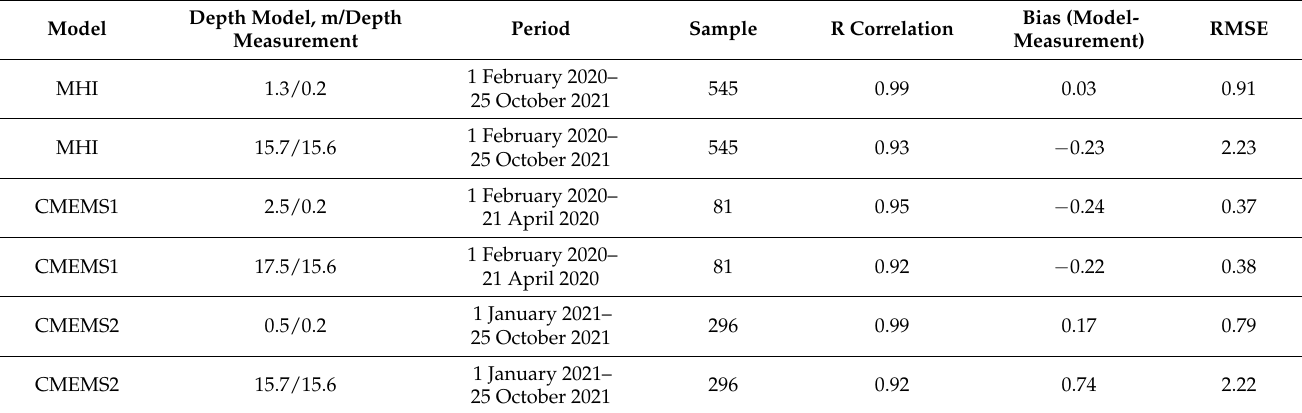
Table 4. Main statistical parameters for MHI and CMEMS1/2 models.